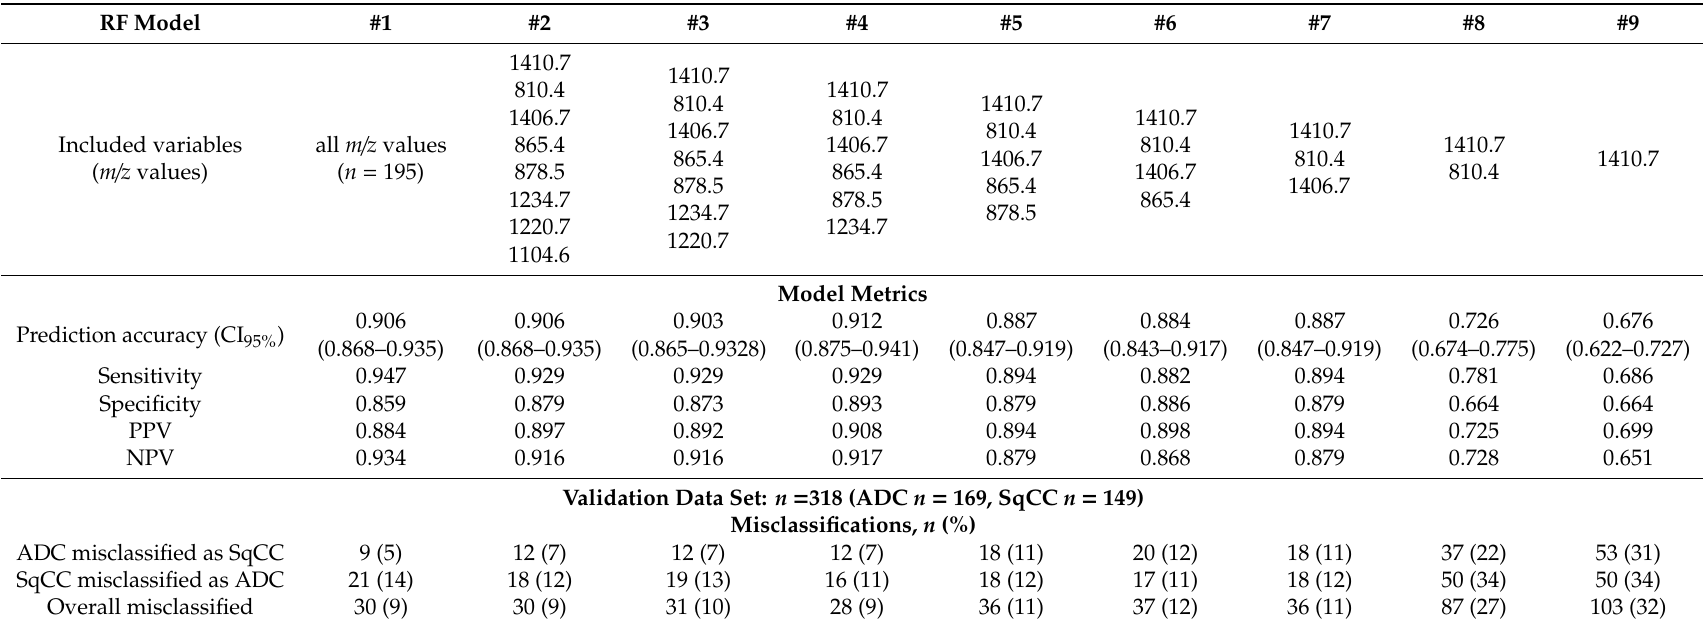
Table 2. Accuracy of the classification algorithm with subsequent reduction in included m / z